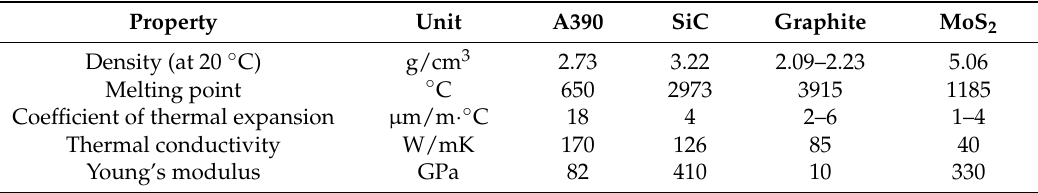
Table 2. Properties of matrix alloy and constituent agents of hybrid aluminum matrix composites